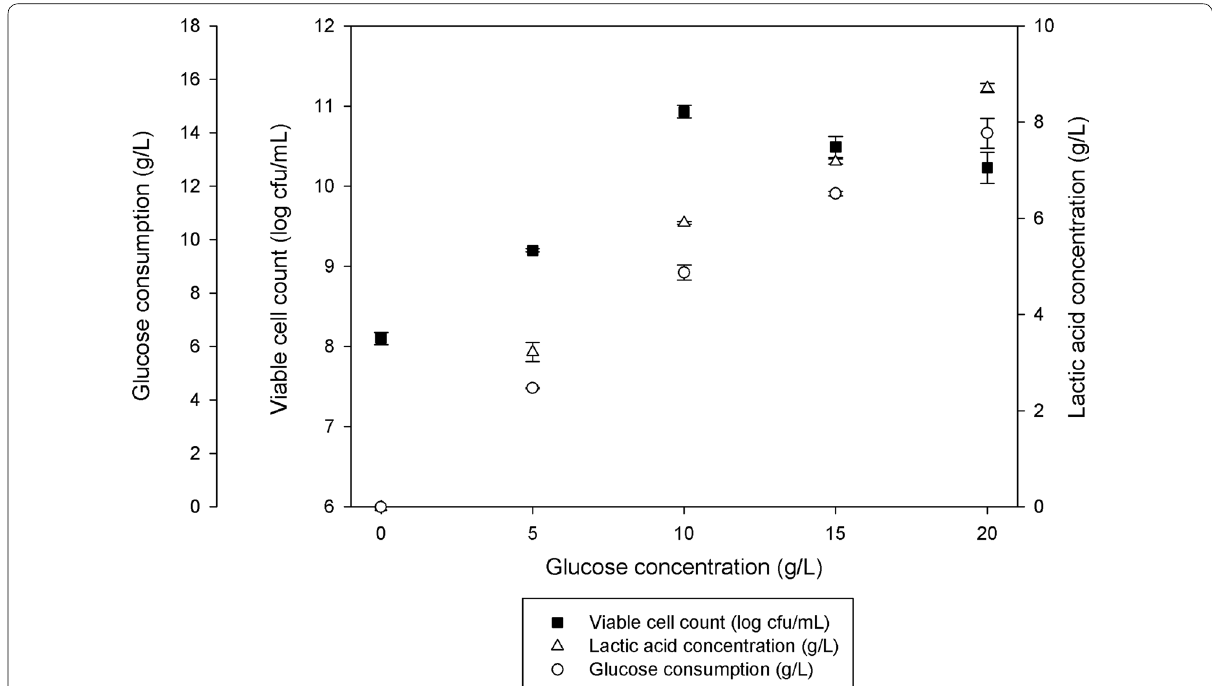
Fig. 1 Effect of glucose concentration on growth of P. acidilactici and lactic acid accumulation. The fermentation was conducted in 500 mL shake flask, at 200 rpm. The data are the average of triplicate experiments. The error bars represent the standard deviations about the mean (n